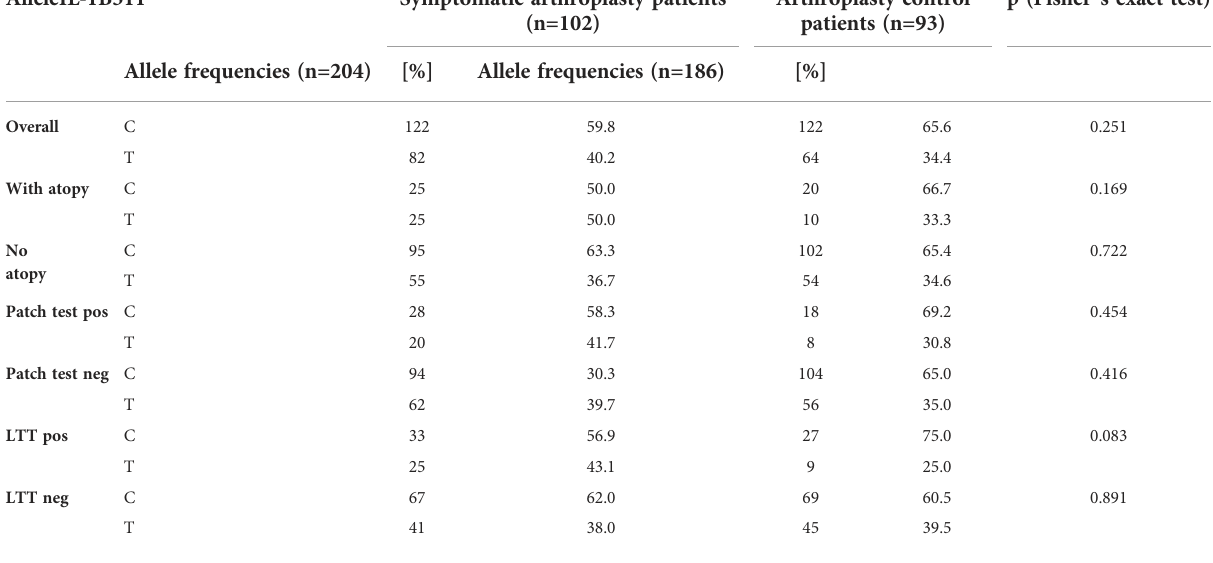
TABLE 6 Allele frequencies of the IL-1B-511 polymorphism including also subgroup analysis. AlleleIL-1B511 Symptomatic arthroplasty patients